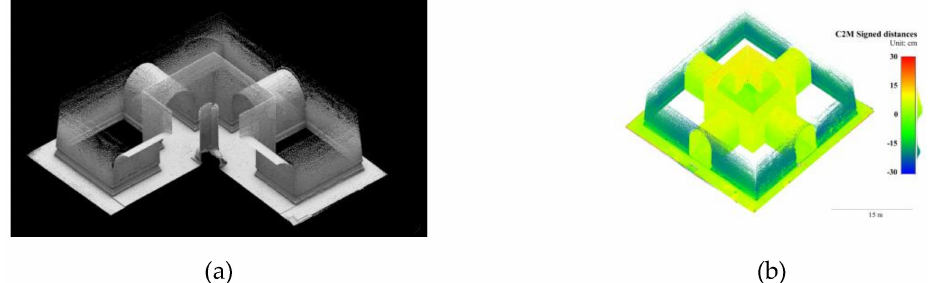
Figure 11. 3D model of the Pavilion dataset obtained with mobile mapping system (MMS; GeoSLAM ZEB-REVO handheld scanner). Compared with that from spherical-camera videogrammetry, the MMS-derived model is (a) less-noisy and (b) has similar global accuracy, but has obvious disjunctions between the outer walls and the